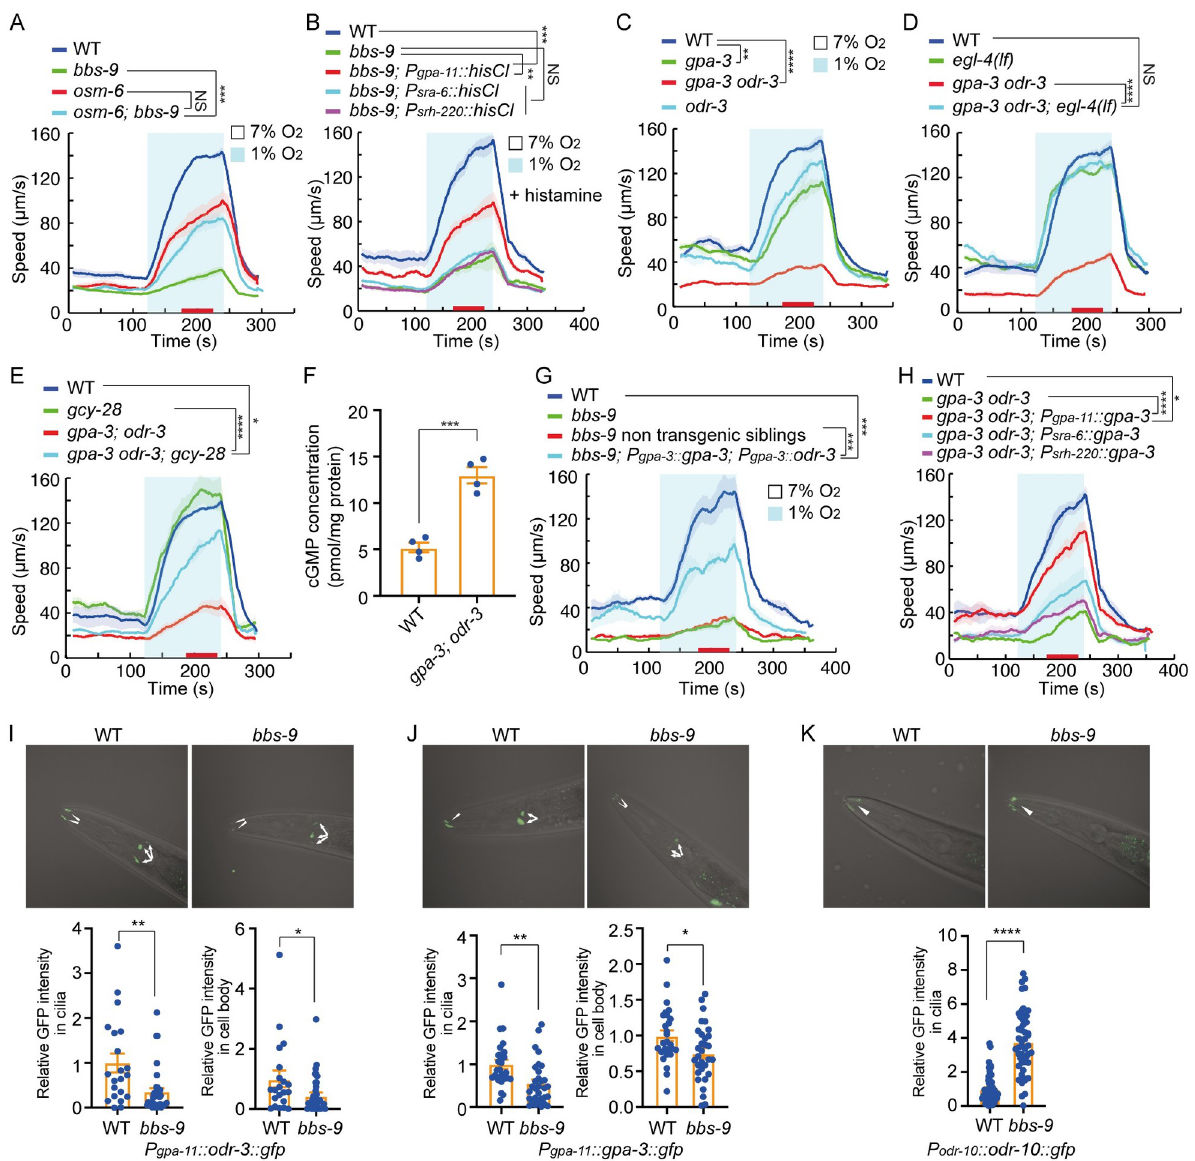
Fig 5. G protein signaling regulates acute responses to hypoxia. (A) Locomotory responses to 7% to 1% O 2 stimuli of animals with indicated genotypes: WT, bbs-9(gk471) , osm-6(p811) , and bbs-9(gk471) ; osm-6(p811) double mutants. ��� = p < 0 . 001 , NS = not significant. ANOVA, Tukey multiple comparison. (B) Locomotory responses to 7% to 1% O 2 stimuli of animals treated with 10mM histamine: WT, bbs-9(gk471) , bbs-9(gk471) expressing HisCl1 from sra-6 (ASH), srh-220 (ADL) and gpa-11 (ASH and ADL) promoters. ��� = p < 0.001, �� = p < 0.01, and NS = not significant. ANOVA, Tukey multiple comparison. (C–E) Locomotory responses to 7% to 1% O 2 stimuli of animals with indicated genotypes: WT, gpa-3(pk35) , odr-3(n1605) , and gpa-3(pk35) odr-3(n1605) (C); WT, egl-4(n478) , gpa-3(pk35) odr-3(n1605) , and gpa-3(pk35) odr-3(n1605) ; egl-4(n478) triple mutants (D); and WT, gcy-28(yum32) , gpa-3(pk35) odr-3(n1605) , and gpa-3(pk35) odr-3(n1605) ; gcy-28(yum32) triple mutants (E). ���� = p < 0.0001, �� = p < 0.01, and NS = not significant. ANOVA, Tukey multiple comparison. (F) Total cGMP in worm lysates determined by cGMP enzyme immunoassay of indicated genotypes: WT and gpa-3(pk35) odr-3(n1605) double mutants. ��� = p < 0.001. t test. (G and H) Locomotory responses to 7% to 1% O 2 stimuli of animals with indicated genotypes: WT, bbs-9(gk471) , transgenic bbs-9(gk471) expressing gpa-3 and odr-3 transgenes from the gpa-3 promoter and their non-transgenic bbs-9(gk471) siblings (G); WT, gpa-3(pk35) odr-3(n1605) , gpa-3(pk35) odr-3(n1605) expressing gpa-3 cDNA in ADL and ASH neurons ( gpa-11p ), in ASH ( sra-6p ) or ADL ( srh-220p ) alone (H). ���� = p < 0.0001, ��� = p < 0.001, and � = p < 0.05. ANOVA, Tukey multiple comparison. (I and J) Representative images (upper panel) and quantification (lower panel) of GFP-tagged markers in the cilia and neuronal cell bodies of WT and bbs-9(gk471) animals. Arrowheads point to cilia; arrows indicate neuronal cell bodies. The plots quantify GFP in cilia (left) and cell bodies (right). The average values in WT were arbitrarily set to 1, and the GFP signal in bbs-9(gk471) mutants normalized to WT. (I), ODR-3-GFP expressed from the gpa-11 promoter, �� = p < 0.01, � = p < 0.05, t test. (J), GPA-3-GFP expressed from the gpa-11 promoter, �� = p < 0.01, � = p < 0.05, t test. (K) ODR-10-GFP expression in the cilia of AWA neurons. Arrowheads indicate the AWA cilia. The GFP intensity of